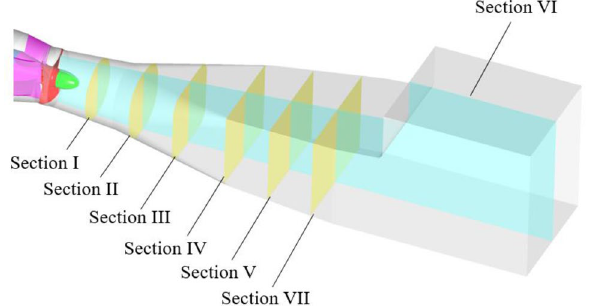
Figure 14. Schematic diagram of a typical cross-section selected for the outlet channel.